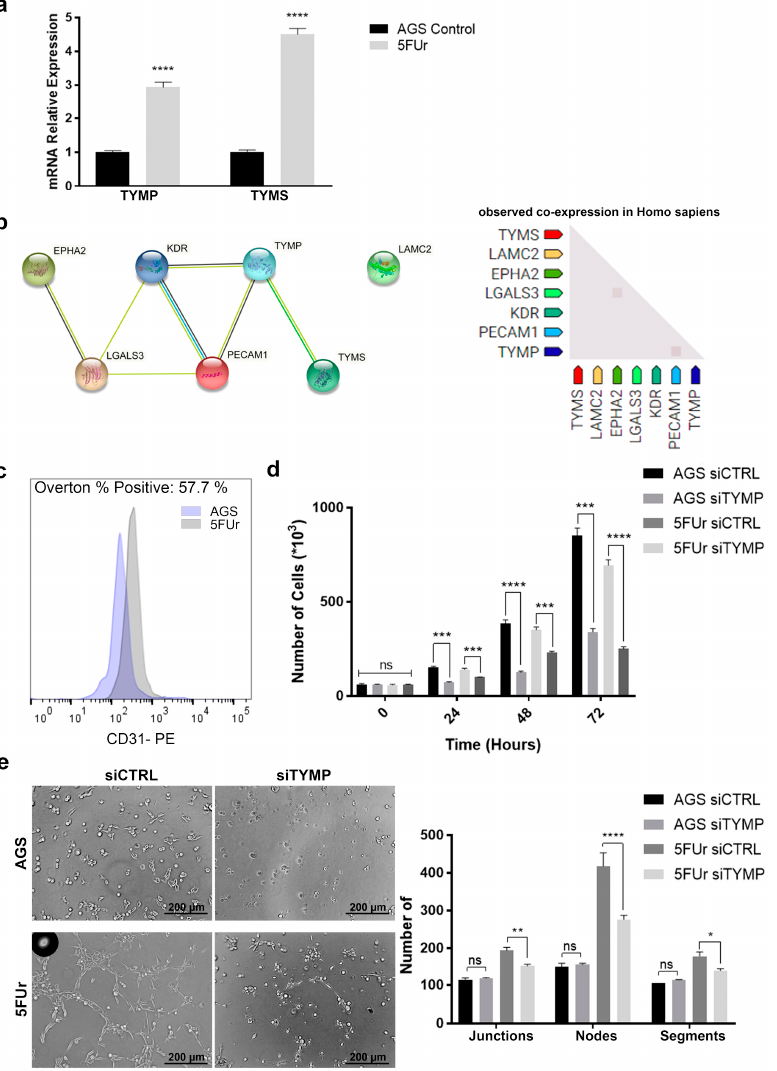
Figure 5. TYMP as the key between vascularization and 5-FU metabolism. ( a ) Total RNA isolated was subjected to RT–PCR analysis of TYMP and TYMS genes. B2M and GAPDH were used as a loading control ( n = 3). ( b ) A comprehensive map of the known and predicted interactions among the previously analyzed angiogenesis-related markers and CD31. ( c ) Cells were tested for CD31 expression by FACS analysis (Overton 57.7% p < 0.0001) ( n = 3). ( d ) Cellular growth counting the total number of cells 24, 48 and 72 h after siRNA transfection. ( n = 3). ( e ) Cells were plated on Matrigel and pictures were taken after 24 h ( n = 3)—scale bar 200 µ m. The representative images and the number of Junctions, Nodes and Segments are presented. Images were captured at 20 × magnification. Data are presented as mean ± SD. ns means not statistically significant; * p < 0.05; ** p < 0.01; *** p < 0.001; **** p < 0.0001 (Two-way ANOVA